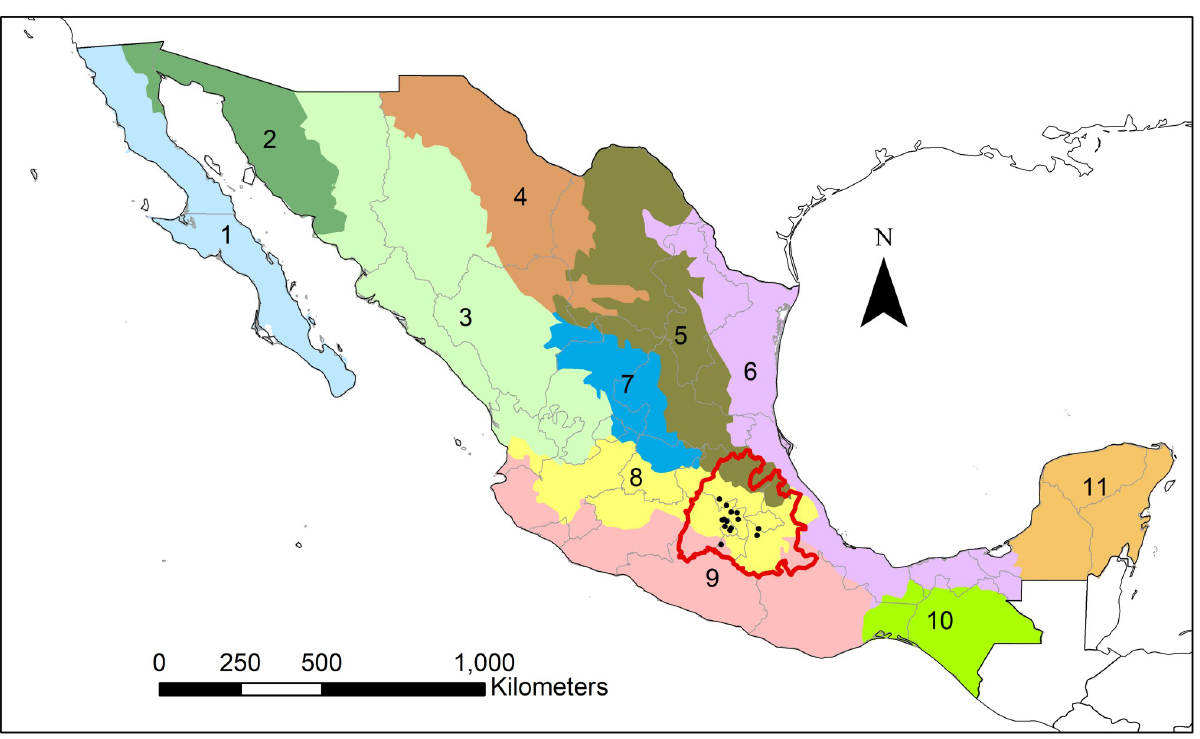
Fig 1. The morphotectonic provinces of Mexico. Central Mexico is outlined in red and is made up by parts of the Sierra Madre Oriental (5), the Mexican Volcanic Belt (8), and the Sierra Madre del Sur (9) morphotectonic provinces. Other morphotectonic provinces include Baja California Peninsula (1), the Northwestern Plains and Sierras (2), the Sierra Madre Occidental (3), the Chihuahua-Coahuila Plateaus and Ranges (4), the Gulf Coast Plain (6), the Central Plateau (7), the Sierra Madre de Chiapas (10), and the Yucata´n Platform (11). Sites included in the study are indicated by black dots. Map created by SIPF with free vector and raster map data from Natural Earth [57]. Morphotectonic data adapted from the Mexican Geological Service [58].